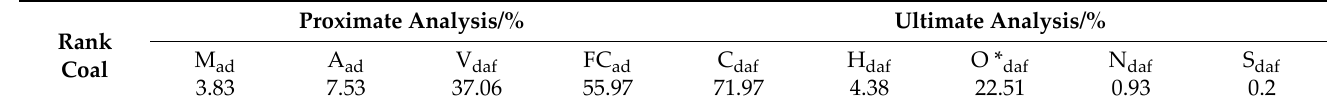
Table 1. Proximate analysis and ultimate analysis of coal samples. Proximate Analysis/% Ultimate Analysis/% Rank M Coal